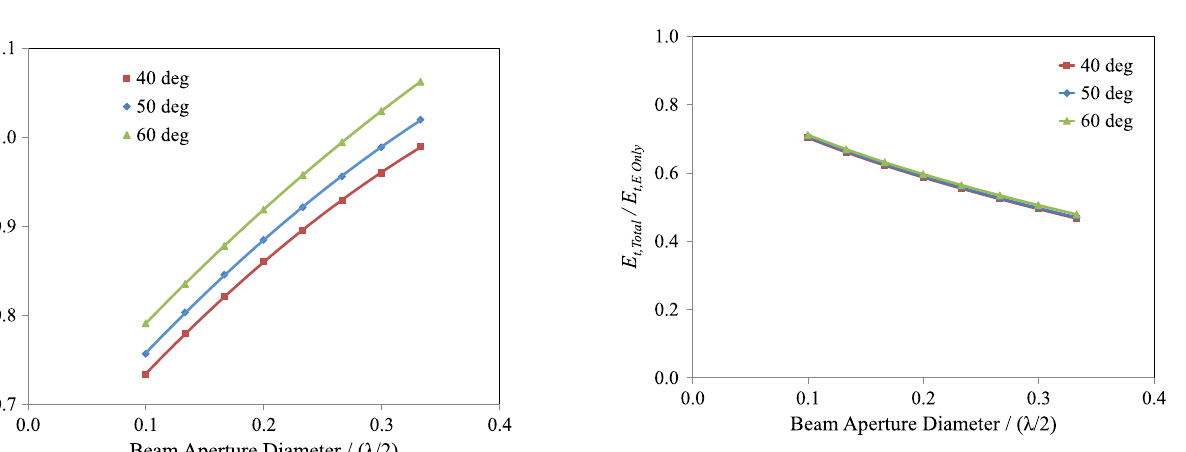
FIG. 34. Cavity diameter with varying beam aperture diameter and angle for rf-dipole design with trapezoidal-shaped bars.